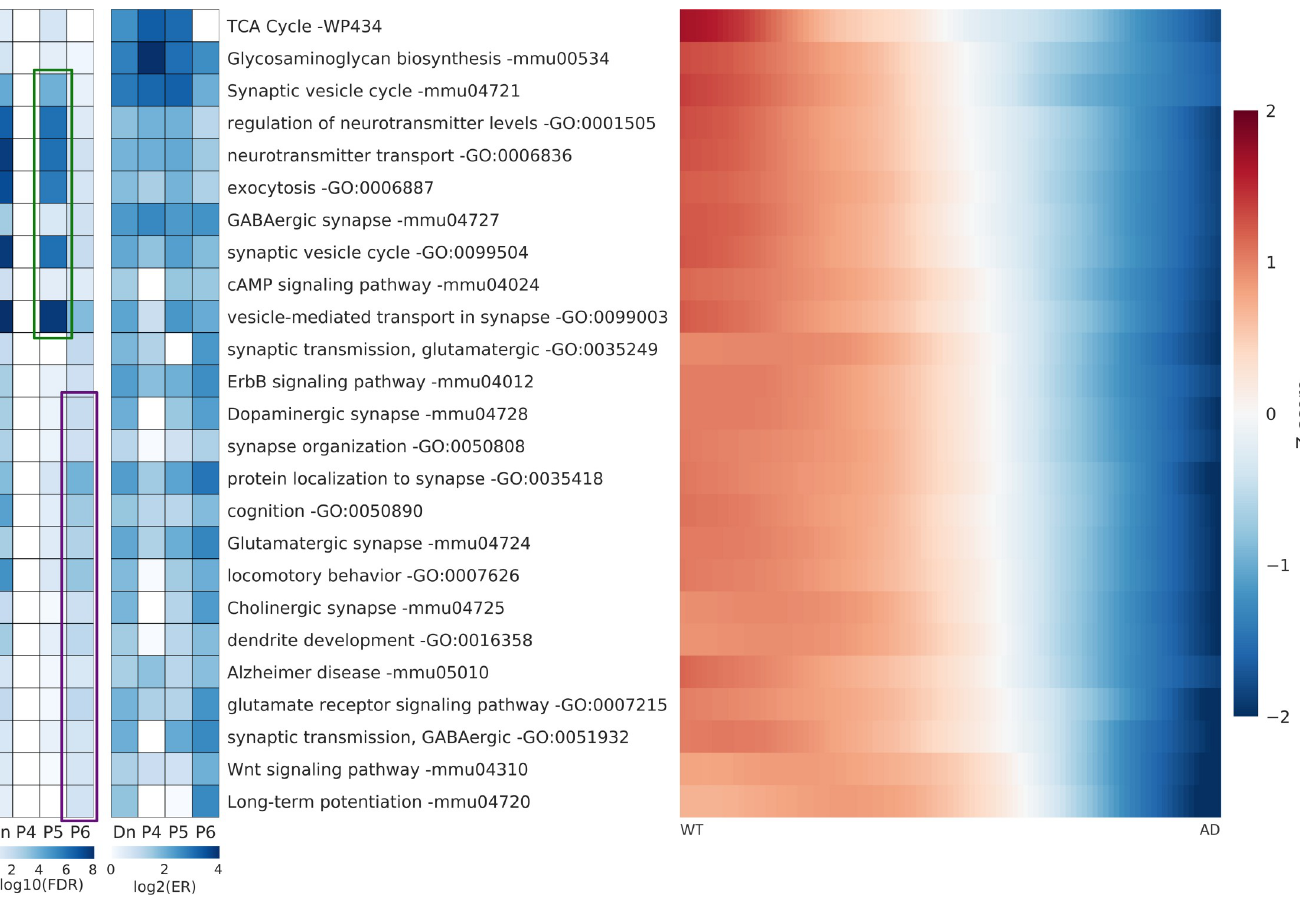
PLOS Computational Biology | https://doi.org/10.1371/journal.pcbi.1008099 July 24,